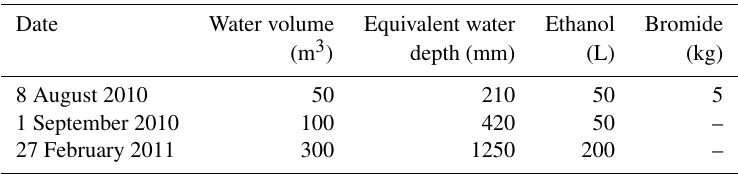
Table 2. Infiltration experiment